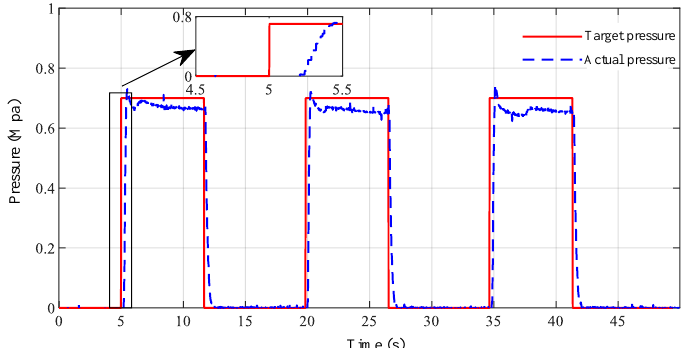
Figure 14. Air pressure response curve of 0.7 MPa target pressure during braking.